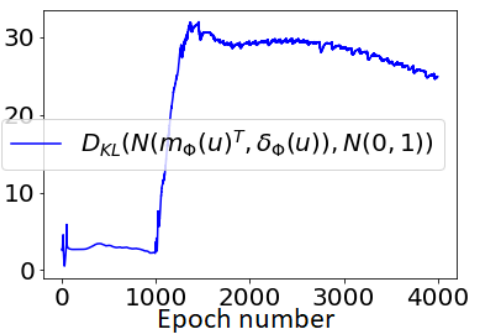
2 (cid:16) ∑ + m 2 − 1 − ln ( s 2 s 2 i i 2 i = 1